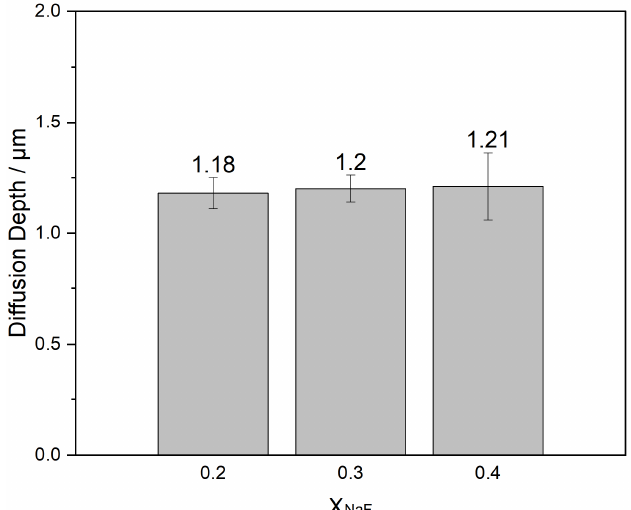
Figure 4. The thickness of the vanadium deposition layer of specimens corresponding to different NaF contents.